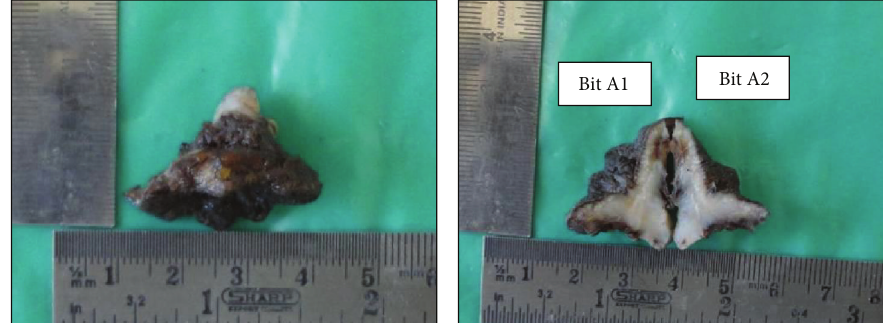
Figure 4: Gross specimen photograph of the excisional biopsy.